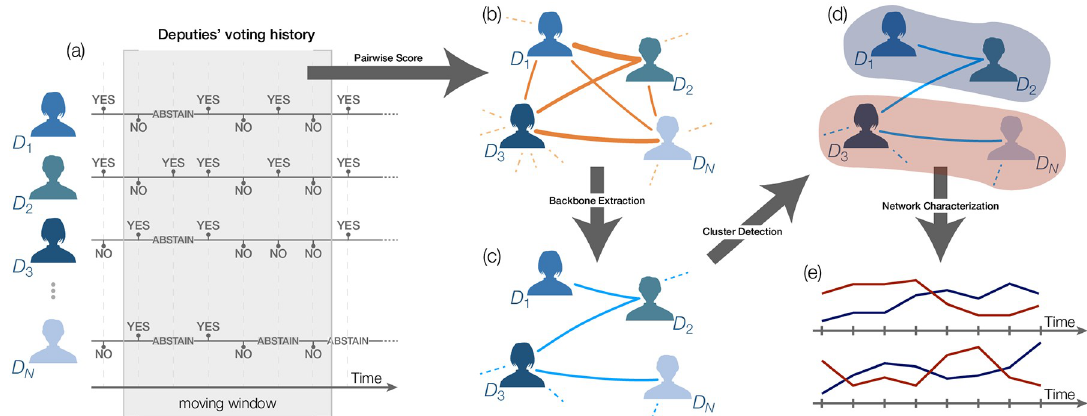
Fig 1. Schematic representing the methodology in this paper. In (a), the voting data is analyzed. In (b), the pairwise similarity of votes in distinct propositions generates a weighted network of deputies. Edges weight represent the distance between two deputies, according to their voting behavior. In (c), edges are filtered so as to preserve the community structure. In (d), we identify the community structure of the network. Finally, in (e), the resulting network is analyzed by measuring e.g. distance between parties.